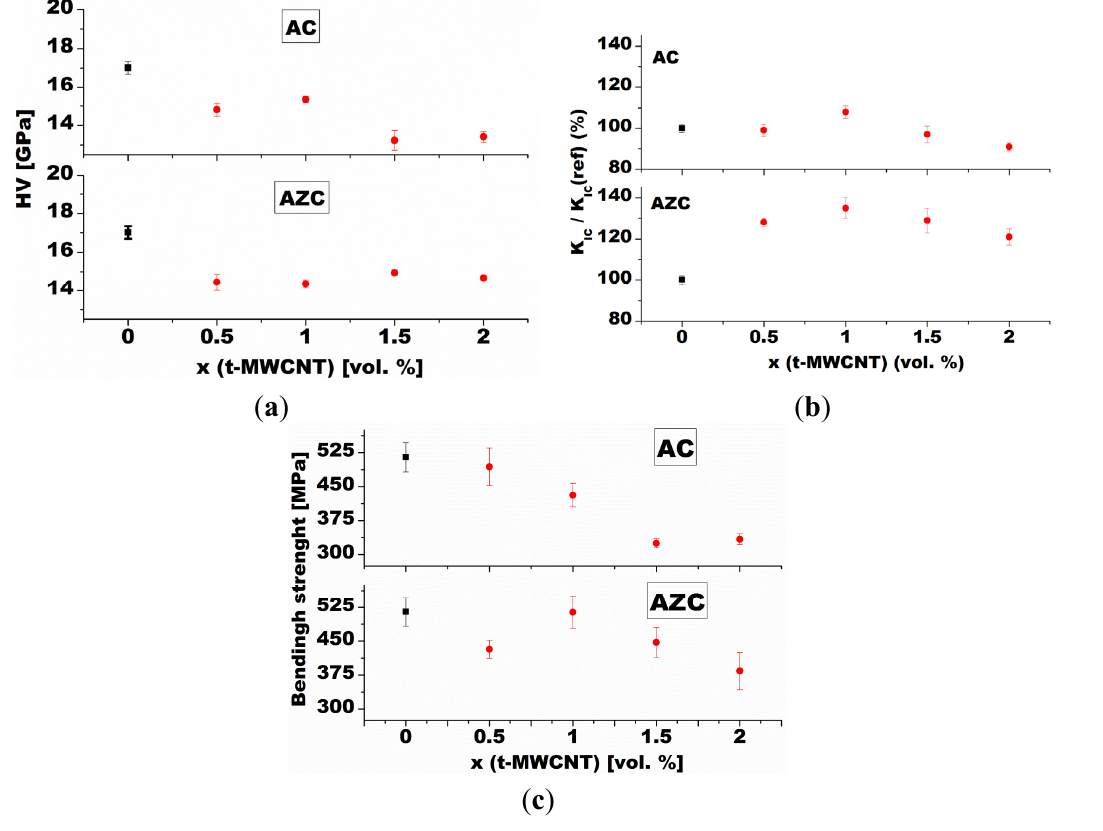
Figure 3. Composition dependence of ( a ) hardness; ( b ) fracture toughness; and ( c ) fracture strength of Al 2 O 3 -MWCNT (denoted AC) and Al 2 O 3 -ZrO 2 -MWCNT (denoted AZC) nanocomposites. Comparison to monolithic alumina reference [95]. Red circles represent the respective properties of nanocomposite with various volume fractions of MWCNT. Black squares represent the same property of the monolithic alumina